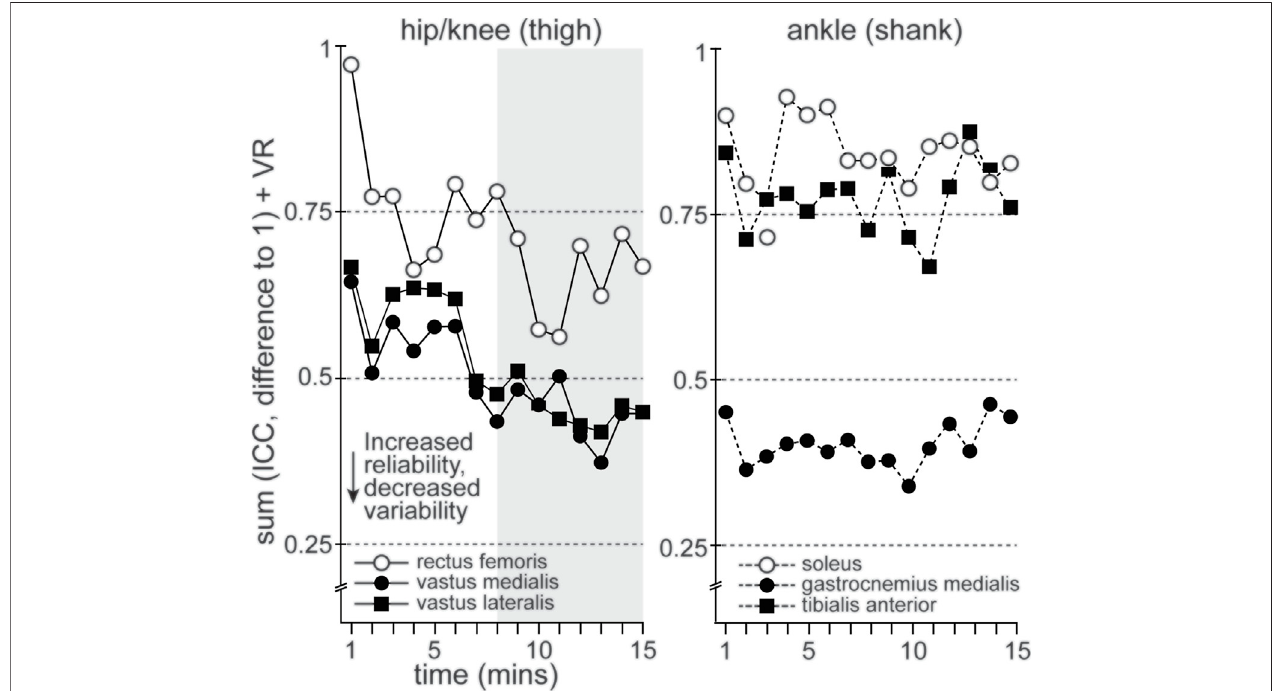
FIGURE 4 | Plots the summation of group mean ICC (difference from 1.0) and VR values, based on joint articulation (hip/knee and ankle) during 15 min of ECC cycling, to contextualize the mean time to familiarization. RF, VL and VM muscles (hip/knee joint) show a descending trend, representing improved reliability with decreased